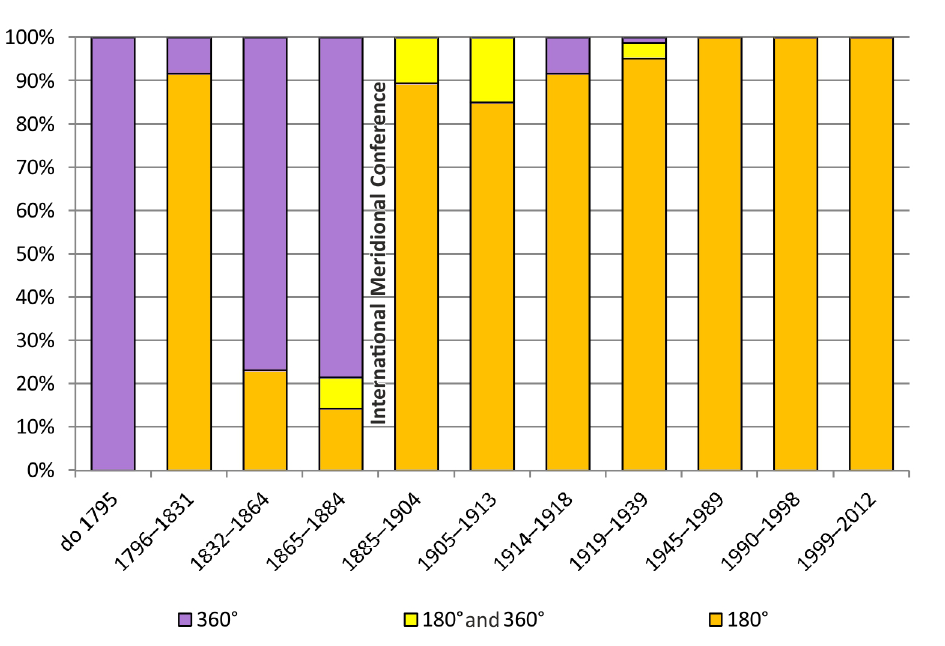
Fig. 6. The structure of atlases in the particular historical periods according to the applied system of determin- ing the longitude. 180° + 360° category applies only to the W. Hardt’s atlas for the folk schools (eight editions and circulations in the years of 1883−1930 [13 and 14]) with the map of the world in the Mercator projection and the longitude notation from 0° to